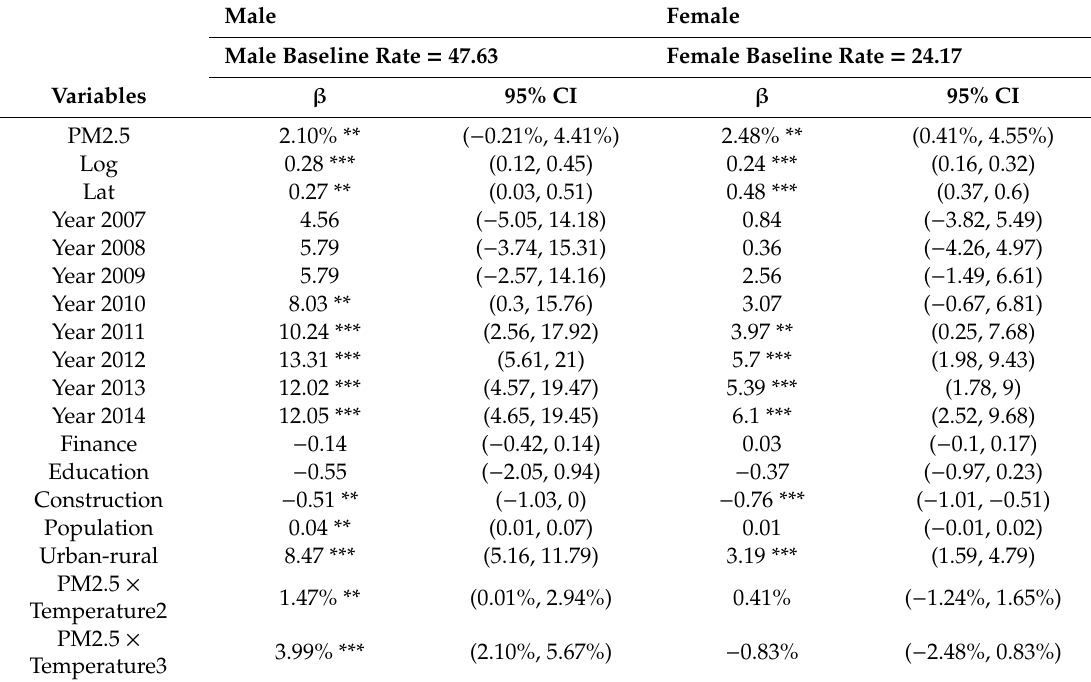
Table 8. Modification e ff ects of